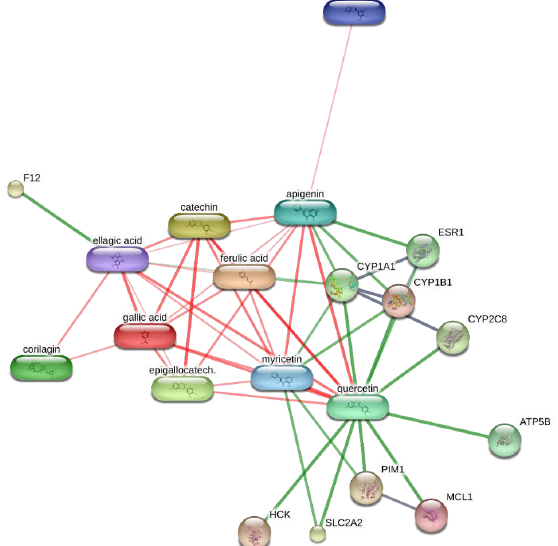
Figure 2. Components–targets analysis built through the bioinformatics STITCH platform that predicted interactions between extracts’ phytochemicals (quercetin, gallic acid, ellagic acid, catechin, apigenin, corilagin, epigallocatechin, myricetin, ferulic acid, tricin) and human multiple protein classes, including kinases and